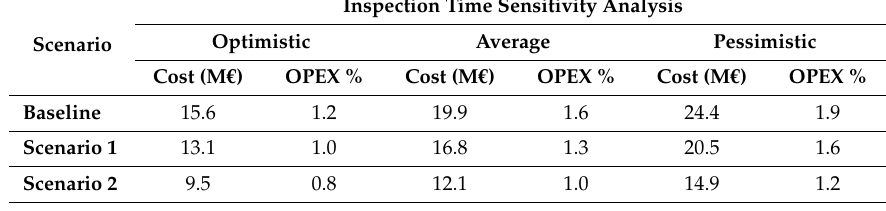
Table 17. Lifetime inspection costs and inspection-time sensitivity analysis for Baseline case, Scenario 1, 2 and 3.